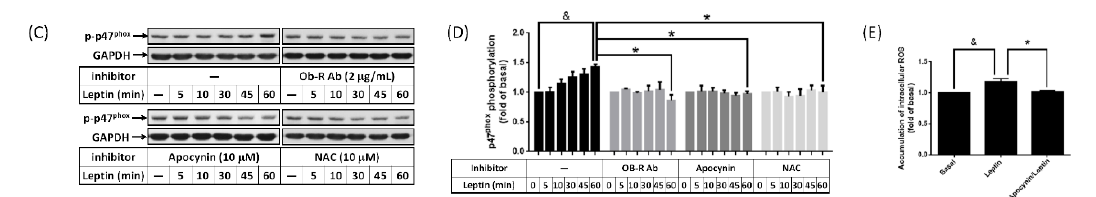
Figure 3. Leptin stimulated expression of cPLA2 and COX-2 via activation of NADPH oxidase. ( A ) ICR mice were i.p. injected with 2 mg/Kg of apocynin for 1 h then i.t. injected with 2 mg/Kg of leptin for 48 h. Expression of cPLA2 (top panel) and COX-2 (bottom panel) was shown by IHC. The